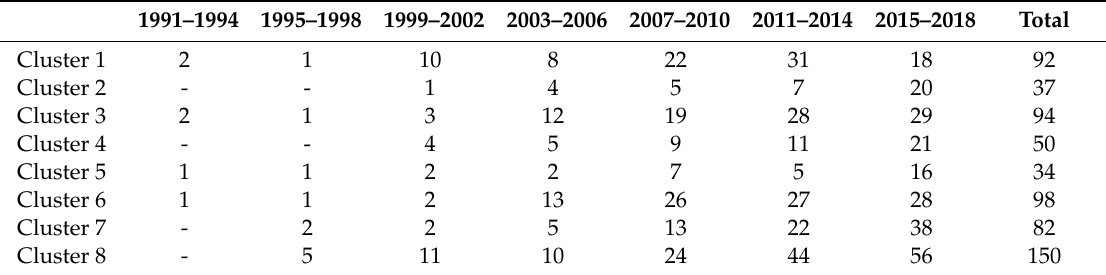
Table 4. Evolution of the number of publications in the thematic clusters between 1991 and